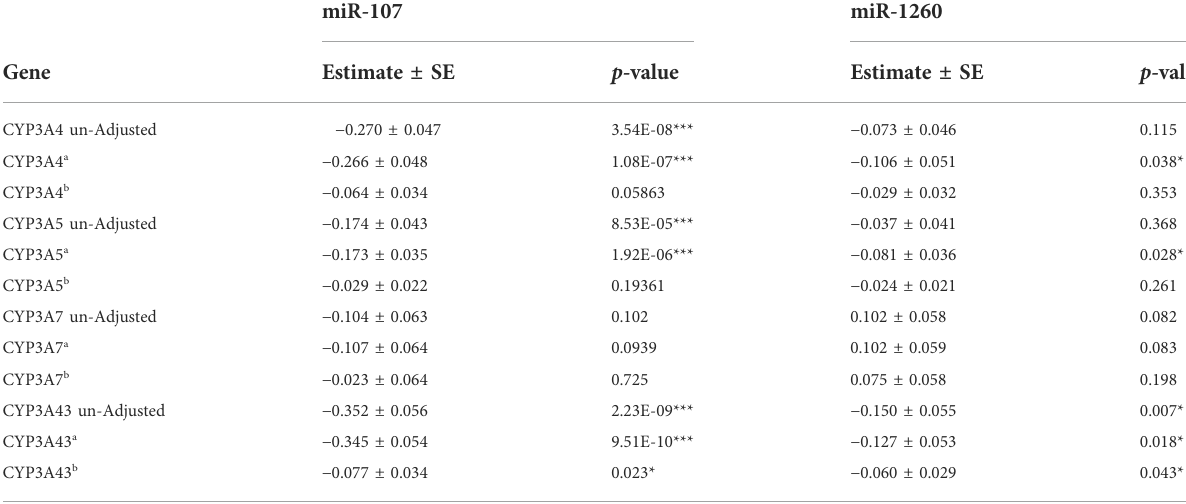
TABLE 1 Association between the expression levels of miR-107/miR-1260 and the CYP3A genes in human liver samples ( n = 231) using linear regression